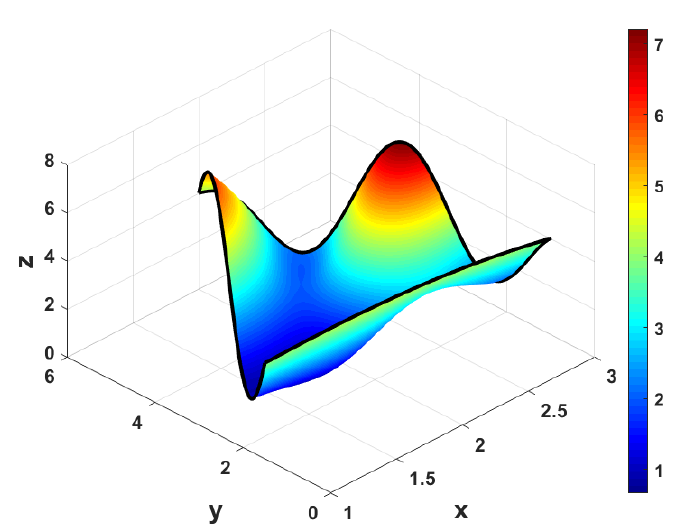
Figure 9. ToC Triangular Surface with g ( x , y ) = 0.